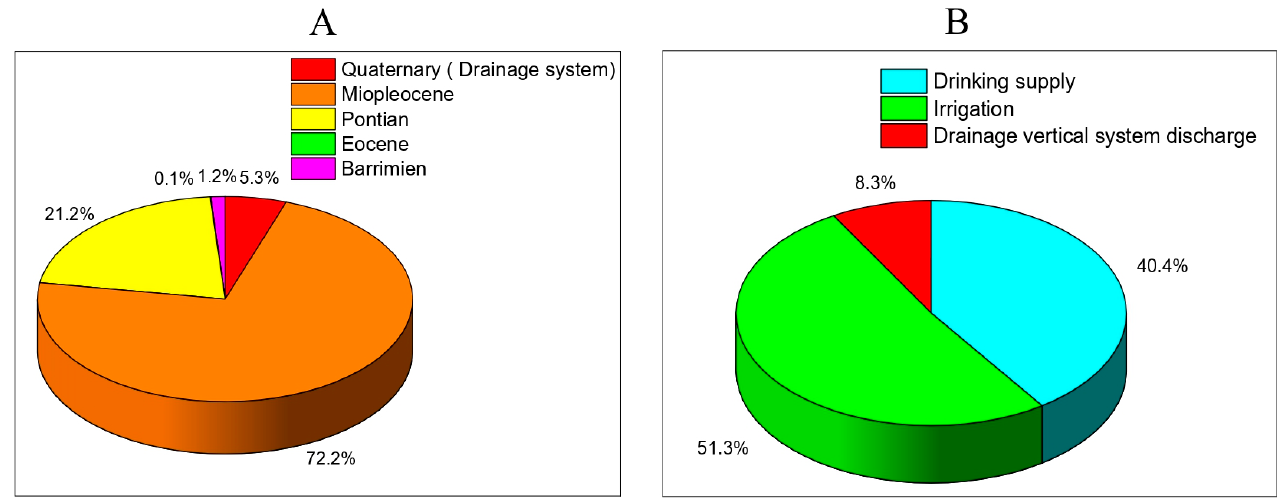
Figure 12. ( A ). Distribution of the extracted water in percentage from the aquifer system of the study area; ( B ). Distribution of the extracted water in percentage depending on the usage.